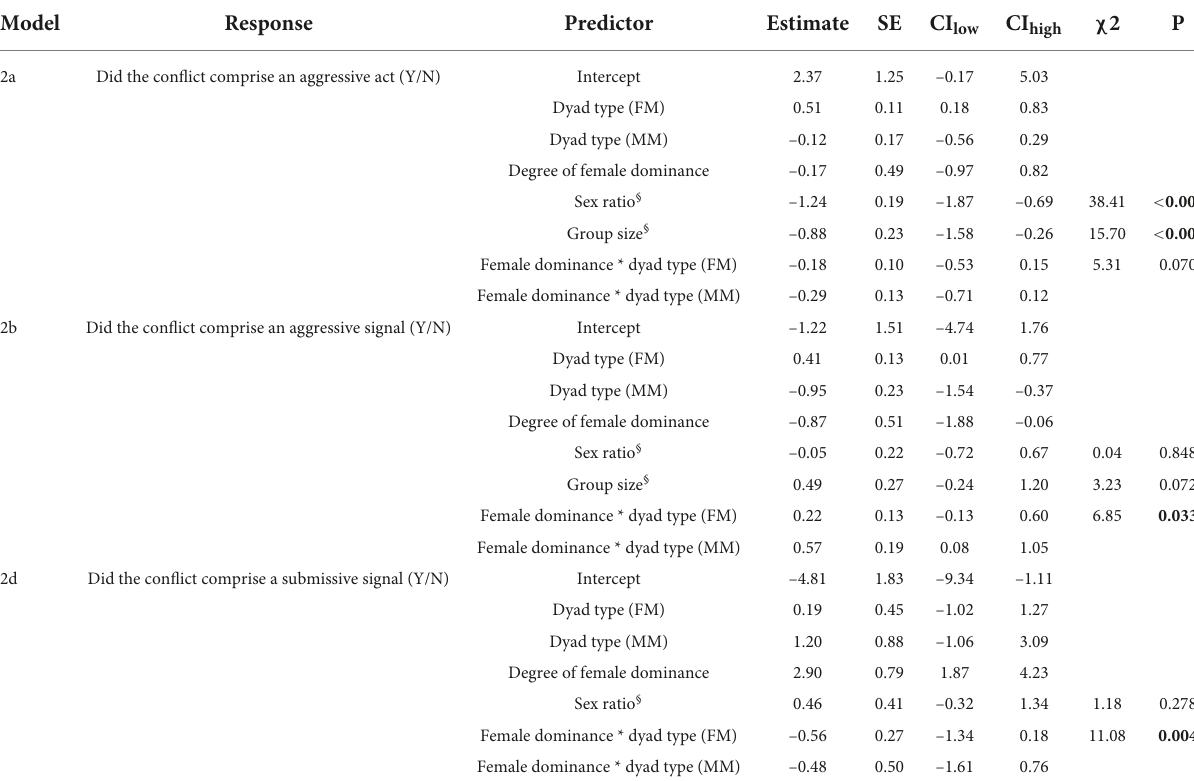
TABLE 3 Effect of the degree of female dominance and dyad type (FM, FF, MM) on the probability of using aggressive acts (Model 2a), aggressive signals (Model 2b), and submissive signals (Model 2d).